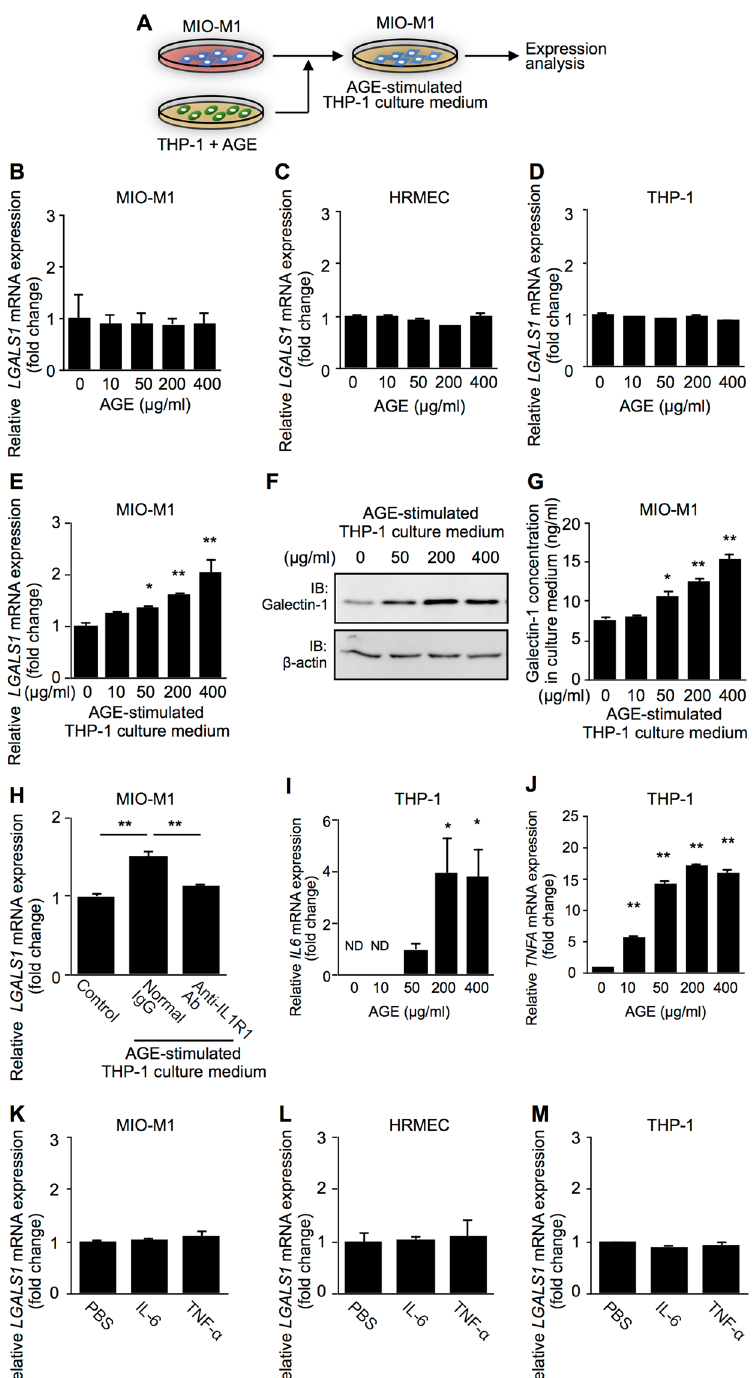
Figure 5. AGE-induced expression of galectin-1 via cellular and molecular inflammatory cues. ( A ) Experimental approach. ( B–D) MIO-M1 ( B ) HRMEC ( C ) and THP-1 ( D ) were directly treated with AGE-BSA (10–400 μ g/ml) for 24 hours, and processed for LGALS1 gene expression. ( E–G ) MIO-M1 was treated with increasing concentrations of AGE-BSA-stimulated THP-1 culture medium for 48 hours, and processed for LGALS1 gene ( E ) and protein (( F ), cell lysates; ( G ), culture media) expression (n = 8 per group). Full-length blots are presented in Supplementary Fig. S6. ( H ) MIO-M1 was pretreated with a neutralizing antibody against IL1R1 (10 μ g/ml) and control normal IgG (10 μ g/ml) for 30 minutes, followed by treatment with AGE-BSA-stimulated THP-1 culture medium for 48 hours, and processed for LGALS1 gene expression. ( I , J ) THP-1 was directly treated with AGE-BSA (10–400 μ g/ml) for 24 hours, and processed for IL6 ( I ) and TNFA ( J ) gene expression. ND, not detected. ( K–M ) MIO-M1 ( K ) HRMEC ( L ) and THP-1 ( M ) were treated with IL-6 (10 ng/ml) and TNF- α (10 ng/ml) for 24 hours, and LGALS1 expression was analyzed. * p < 0.05, ** p < 0.01 (n = 6 per